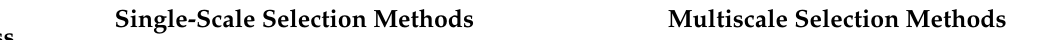
Table 10. OAs of different single scale and multiscale on Salinas dataset with different number of training samples per calss.